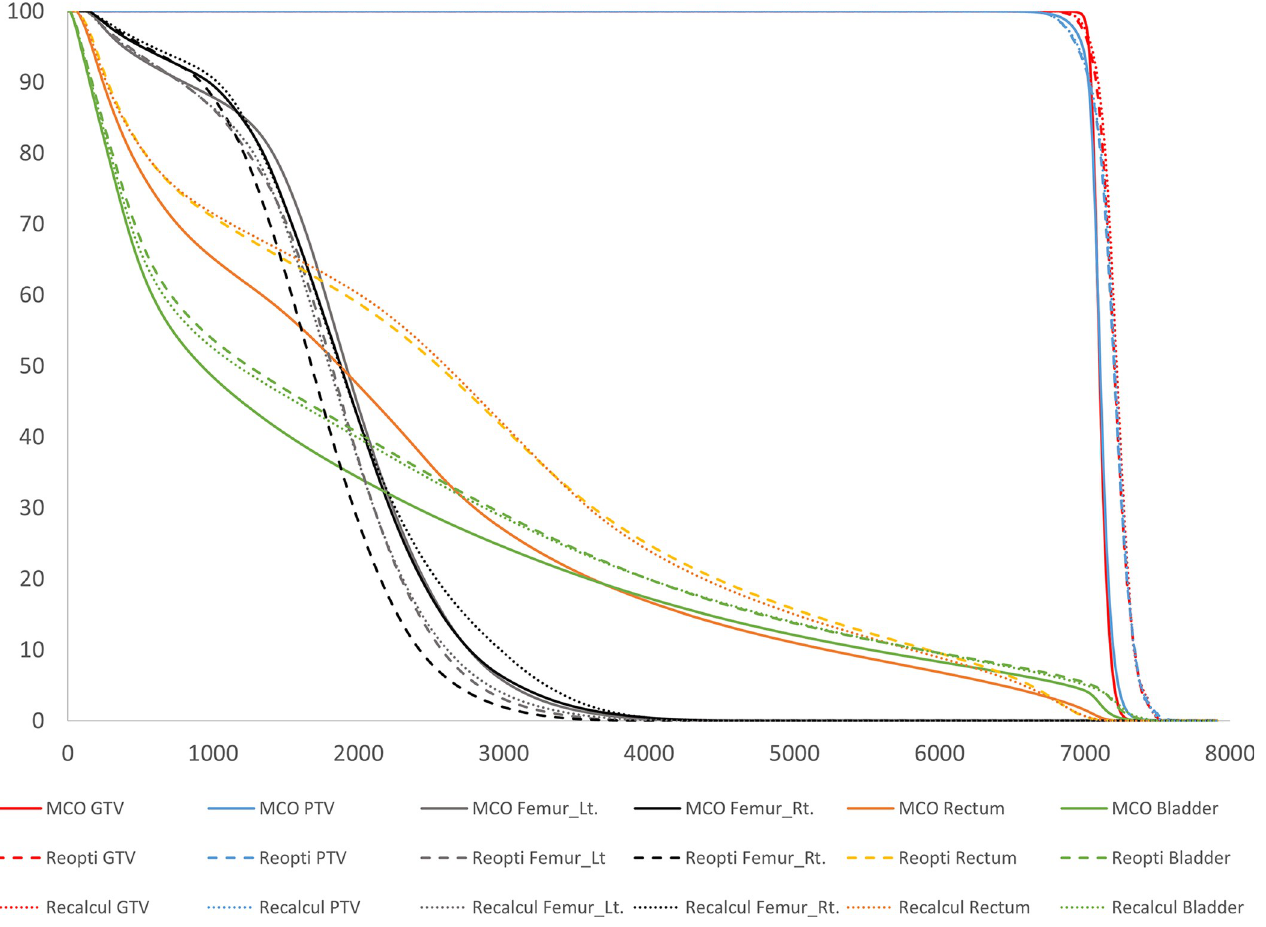
Fig 2. Dose–volume histogram of plans with MCO, with re-optimization and with re-calculation. MCO, multicriteria-optimization; GTV, gross target volume; PTV, planning target volume; Lt, left; Rt, Right. https://doi.org/10.1371/journal.pone.0257216.g002 the D . The MCO plan reduced the D by 48 cGy, to 7120, compared with 7168 of recal- mean mean culation. Re-optimization was however increased by 4 cGy, to 7172 cGy. Furthermore, the MCO plans generated better dose gradient, homogeneity, and conformality. However, the GI of the MCO plan did not show a statistically significant difference when compared with the re- optimization plan (1.55 in MCO and 1.67 in re-optimization, p = 0.65).